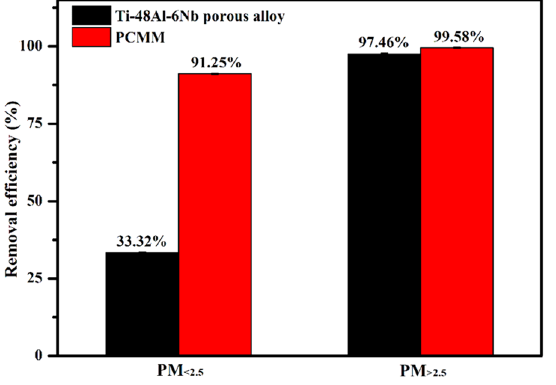
Fig. 10 Removal ef fi ciency of porous sample. Ti-48Al-6Nb porous alloy (black) and PCMM (red) after 60 min fi ltration